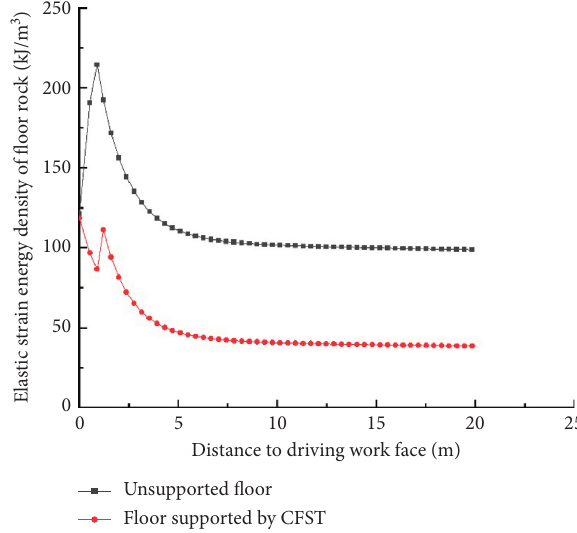
Figure 15: Floor energy evolution curve before and after driving working